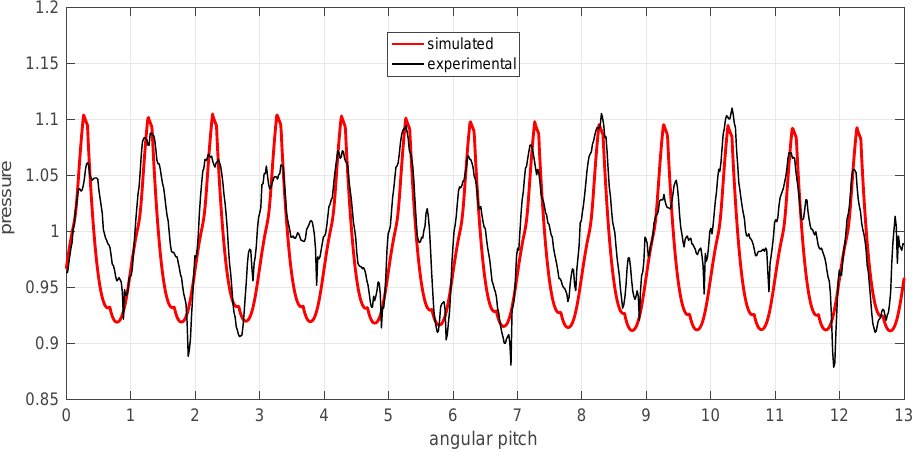
Figure 22. Simulated and experimental instantaneous pressure at 4000 rpm, 6 bar and 65 °C.